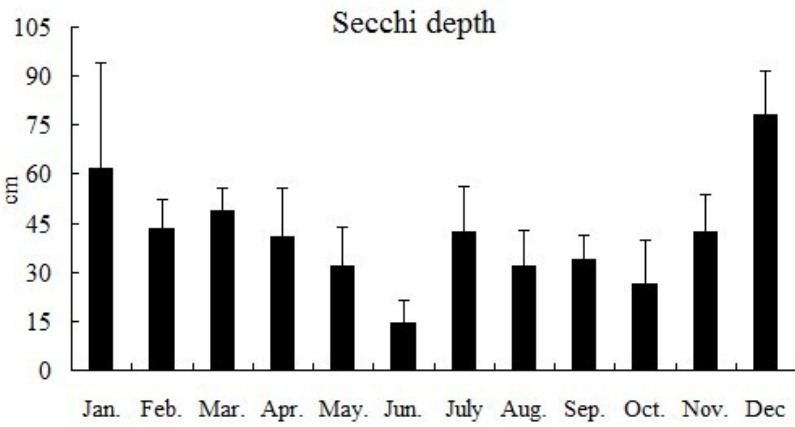
FIGURE 7. Seasonal variations of Secchi depth in Gonghu Bay 2008 (means ± standard